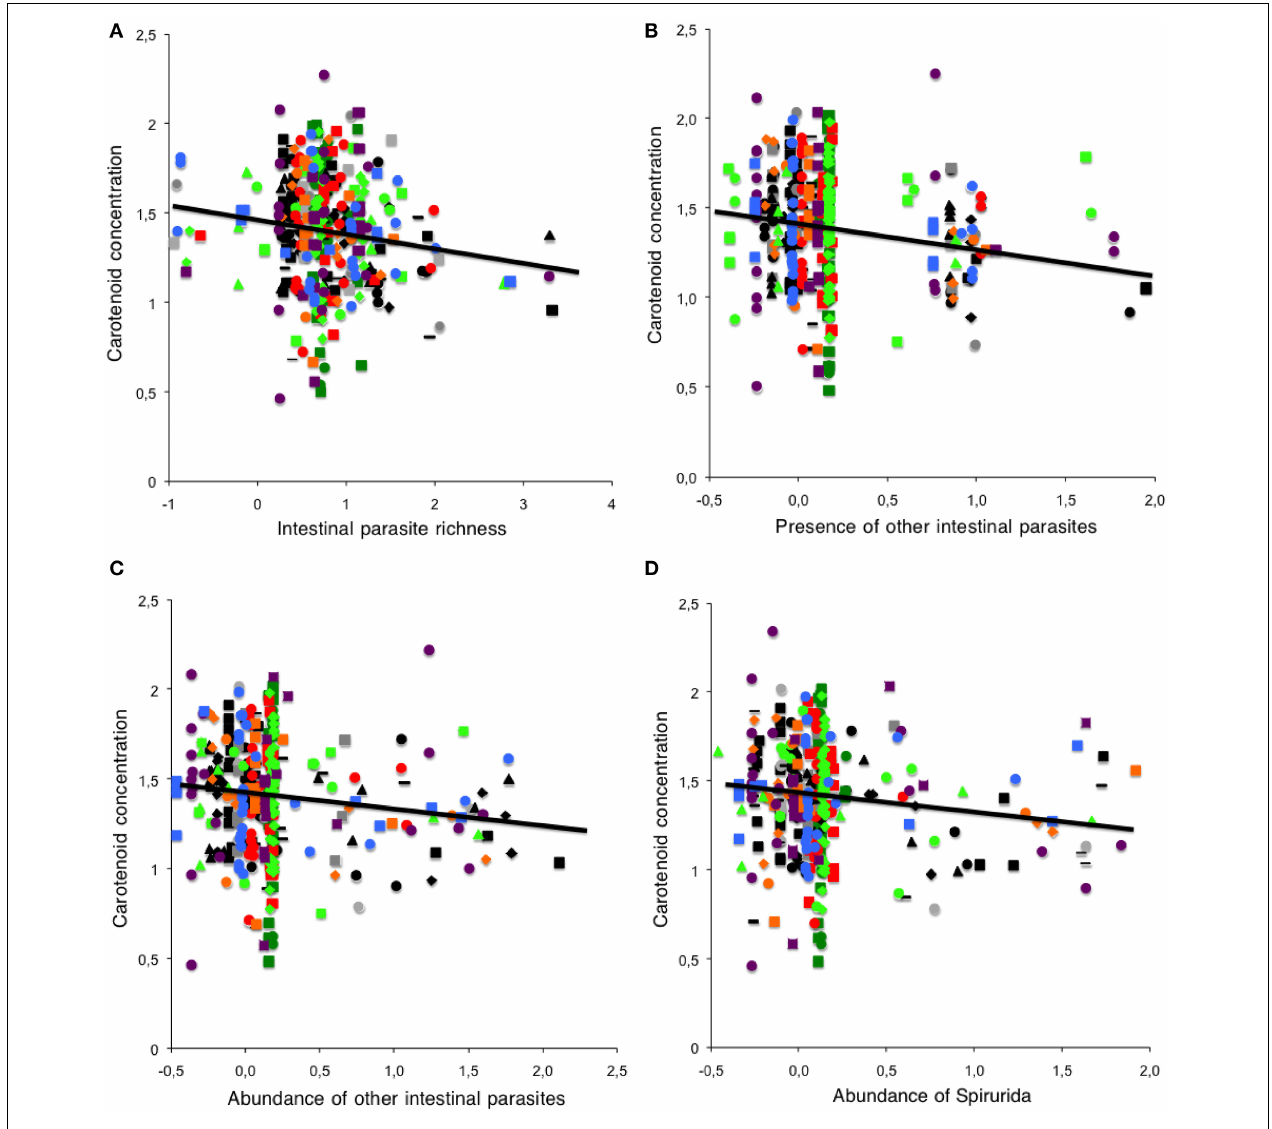
FIGURE 2 | Carotenoid concentrations and parasites. Relationship between carotenoid concentrations ( μ g/ml) in 354 individuals of 22 species of passerines and (A) intestinal parasite richness, (B) prevalence of other